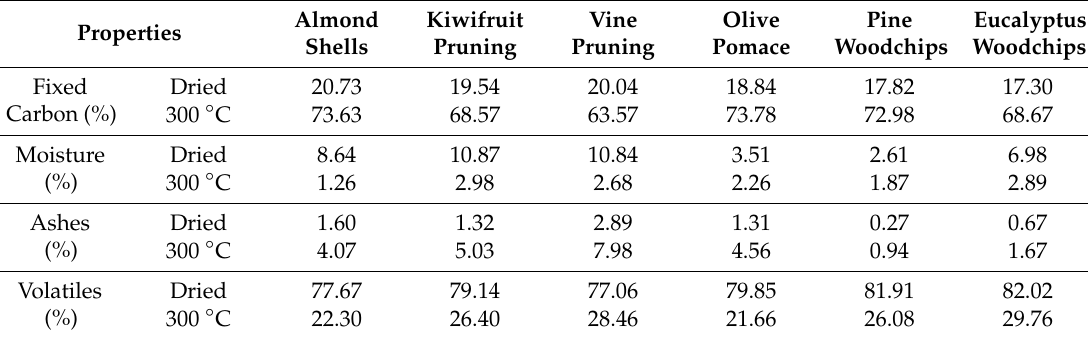
Table 3. Thermogravimetric composition for the di ff erent biomass waste forms.